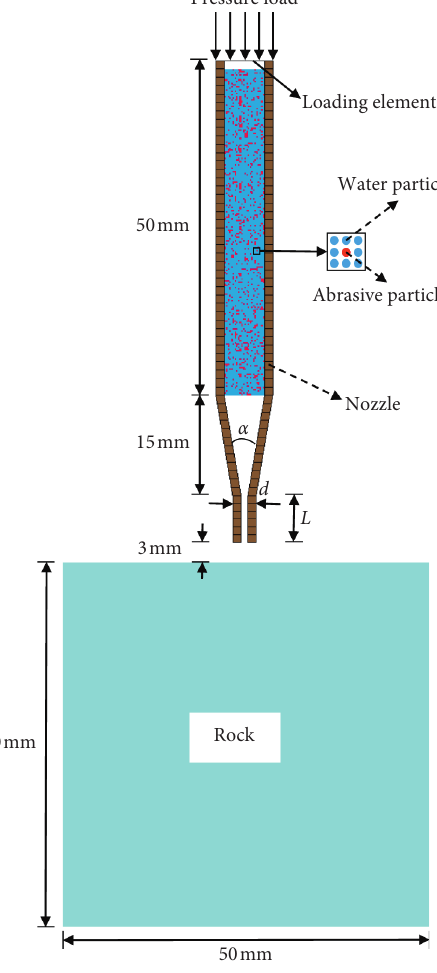
Figure 1: AWJ impacting rock